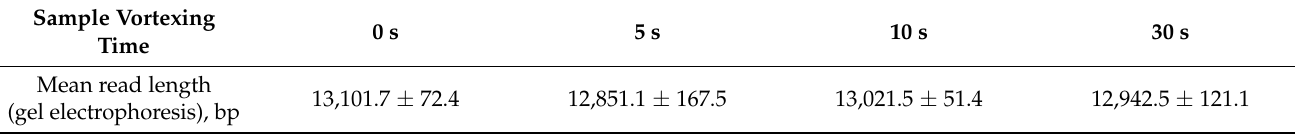
Table A1. Main features of the considered